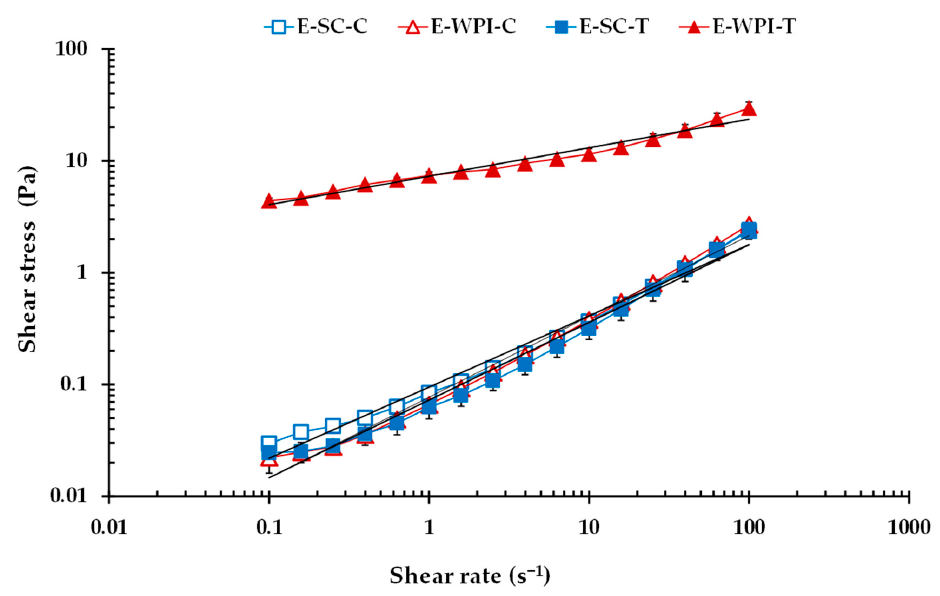
Figure 2. Typical flow curves and applicability of the power law model to liquid-like emulsions (Es) stabilized by two emulsifying proteins (SC and WPI), without (E-SC-C and E-WPI-C) and with added condensed tannins (T) (E-SC-T and E-WPI-T).